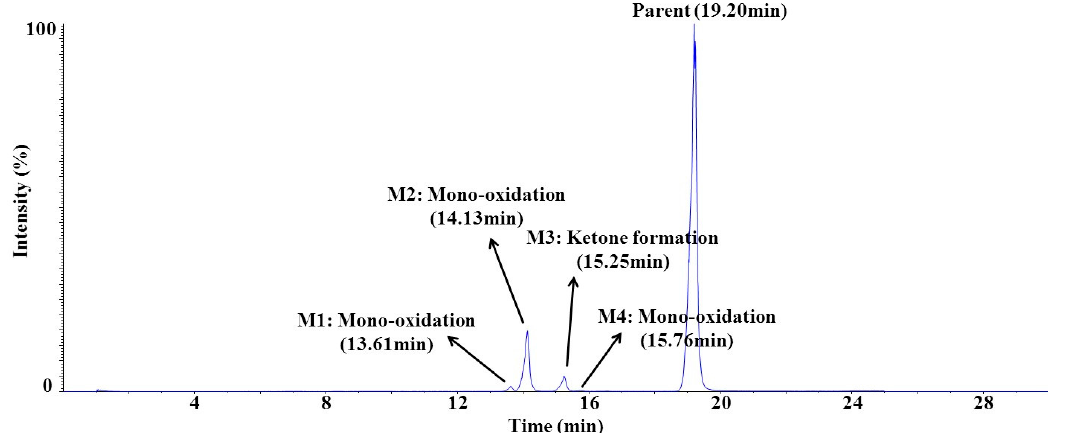
Figure 7. Chromatographic separation of in vitro rat liver microsomes. Table 7. Characteristics of in vitro SCH 58261 metabolite identification results by LC–MS/MS assay.